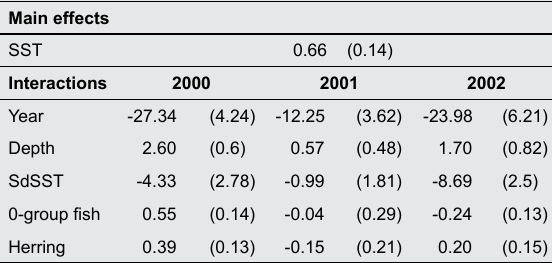
Table 8. Estimates (and SE) of variables in selected model describing sperm whale distributions within the in 2000, 2001 and 2002 within the study area Residual deviance=218.20 (Null deviance=317.94), residual